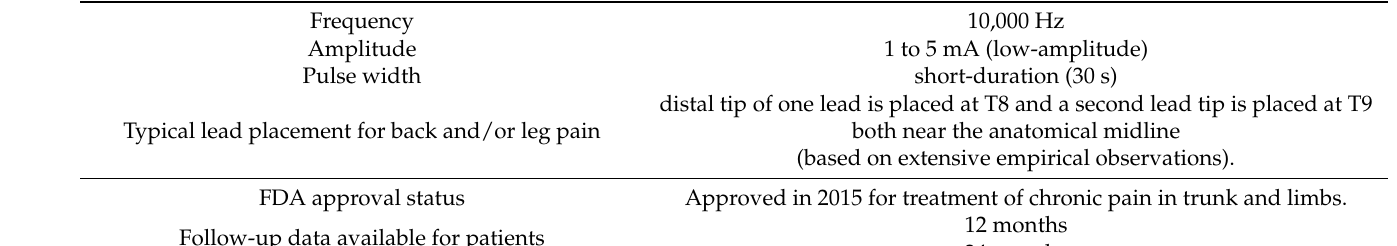
Table 1. Characteristics of 10 kHz SCS.